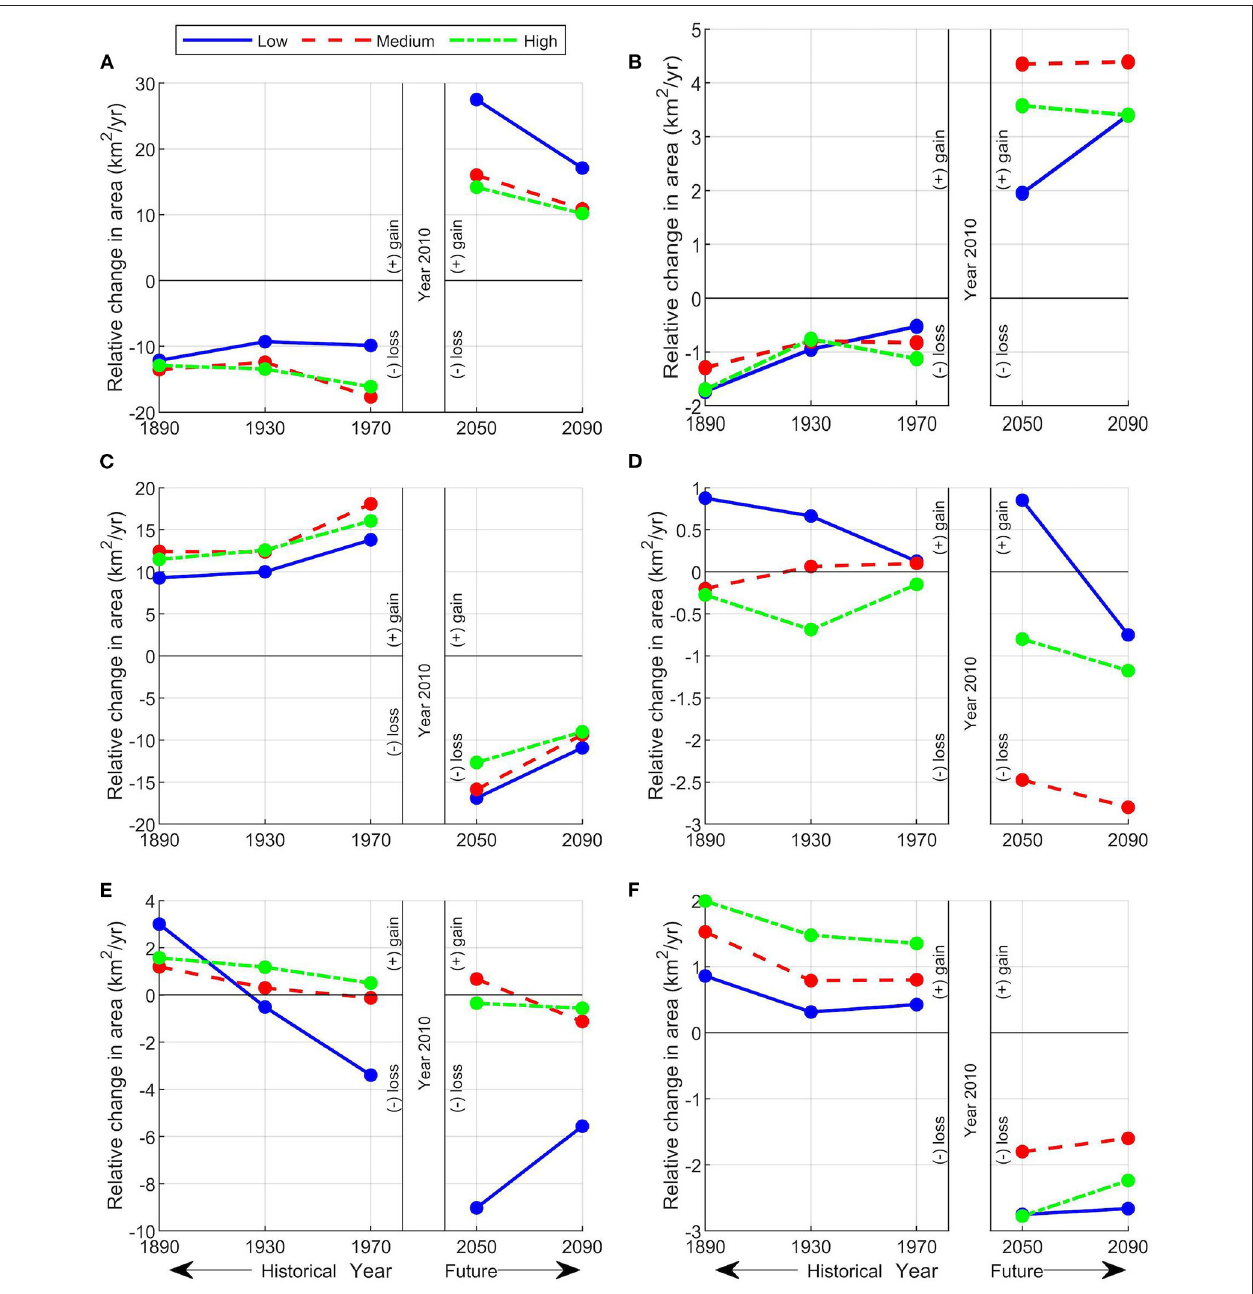
FIGURE 11 | Relative change in coverage area between the historical and future conditions to the 2010 base condition of the (A,B) coastal, (C,D) transition, and (E,F) hydrologic flood zone at the (A,C,E) Barataria and (B,D,F) Lake Maurepas watershed for different flood magnitudes. The blue, red, and green lines represent the low, medium, and high flood events, respectively. Positive values represent that the coverage area of a flood hazard zone for a given era has increased compared to the 2010 base conditions. Negative values represent that the coverage area of a flood hazard zone for a given era has decreased compared to the 2010 base